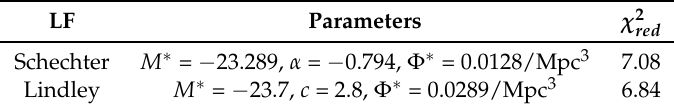
Table 4. Numerical values values and χ 2 when M (cid:12) =